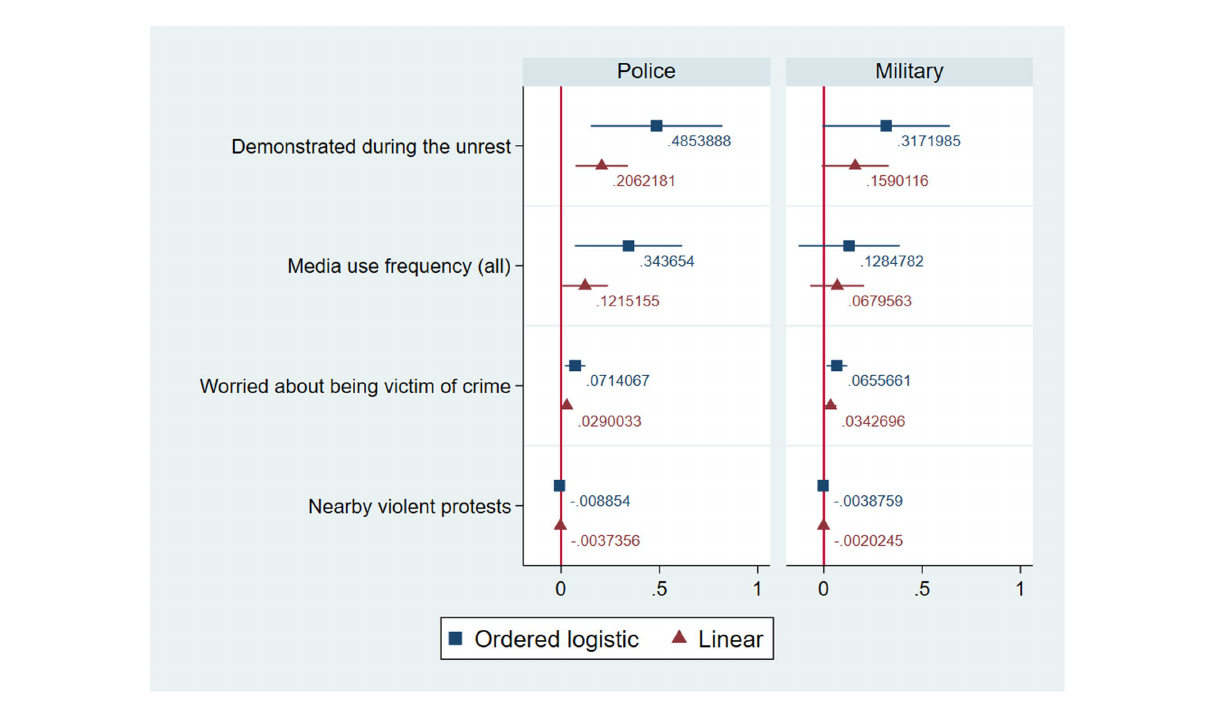
FIGURE 2 Regressions of perceptions of frequency of human rights violations by the police and military during the October crisis (all media), with 95% confidence intervals.